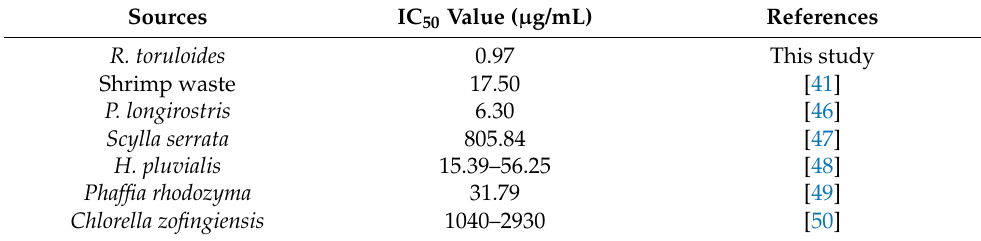
Table 5. DPPH scavenging activity of astaxanthin from different